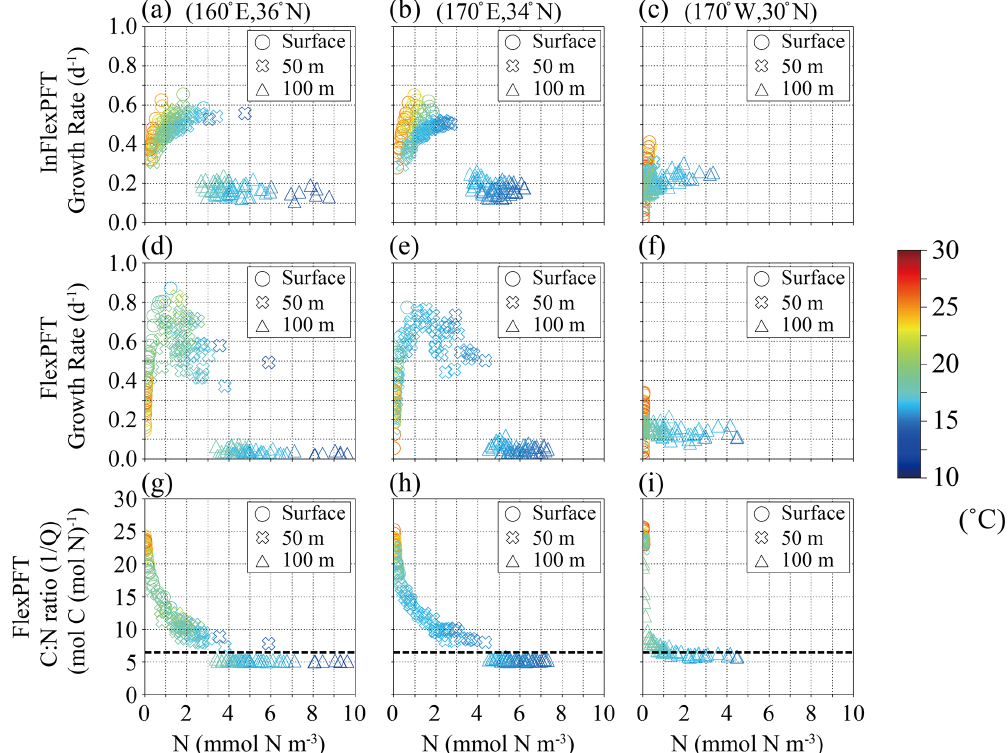
Figure 7. (a) – (f) Monthly mean growth rate (d − 1 ) in summer in 2000–2019 from Fig. 5c and d versus summer monthly mean N concentration (mmolNm − 3 ) from Fig. 3e and f for each depth (circles: surface, crosses: 50m depth, triangles: 100m depth in Fig. 5c and d) and each model, and (g) – (i) summer monthly mean C:N ratio versus summer monthly mean N concentration in the FlexPFT model. The colour in each figure represents the summer monthly mean T ( ◦ C) in Fig. 3h. Dashed lines in (g) , (h) , and (i) represent a constant C:N (106:16 = 6.625) ratio